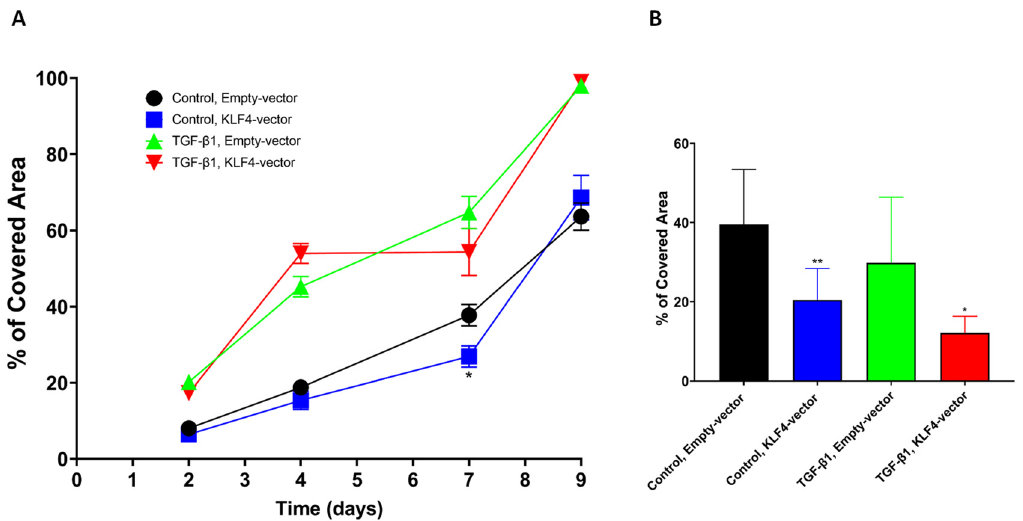
Figure 6. Transient pCMV3-regulated overexpression of KLF4 allows a transient growth reduction of SCC-25 cells ( A ). Twenty-four hours of Cisplatin treatment and plating of 3 × 10 4 cells resulted in significant growth reduction in KLF4-overexpressed cells compared to empty (without insert)— pCMV3 vector transfected cells seven days after 10 µM Cisplatin treatment ( B ). *: less than 0.05; **: less than